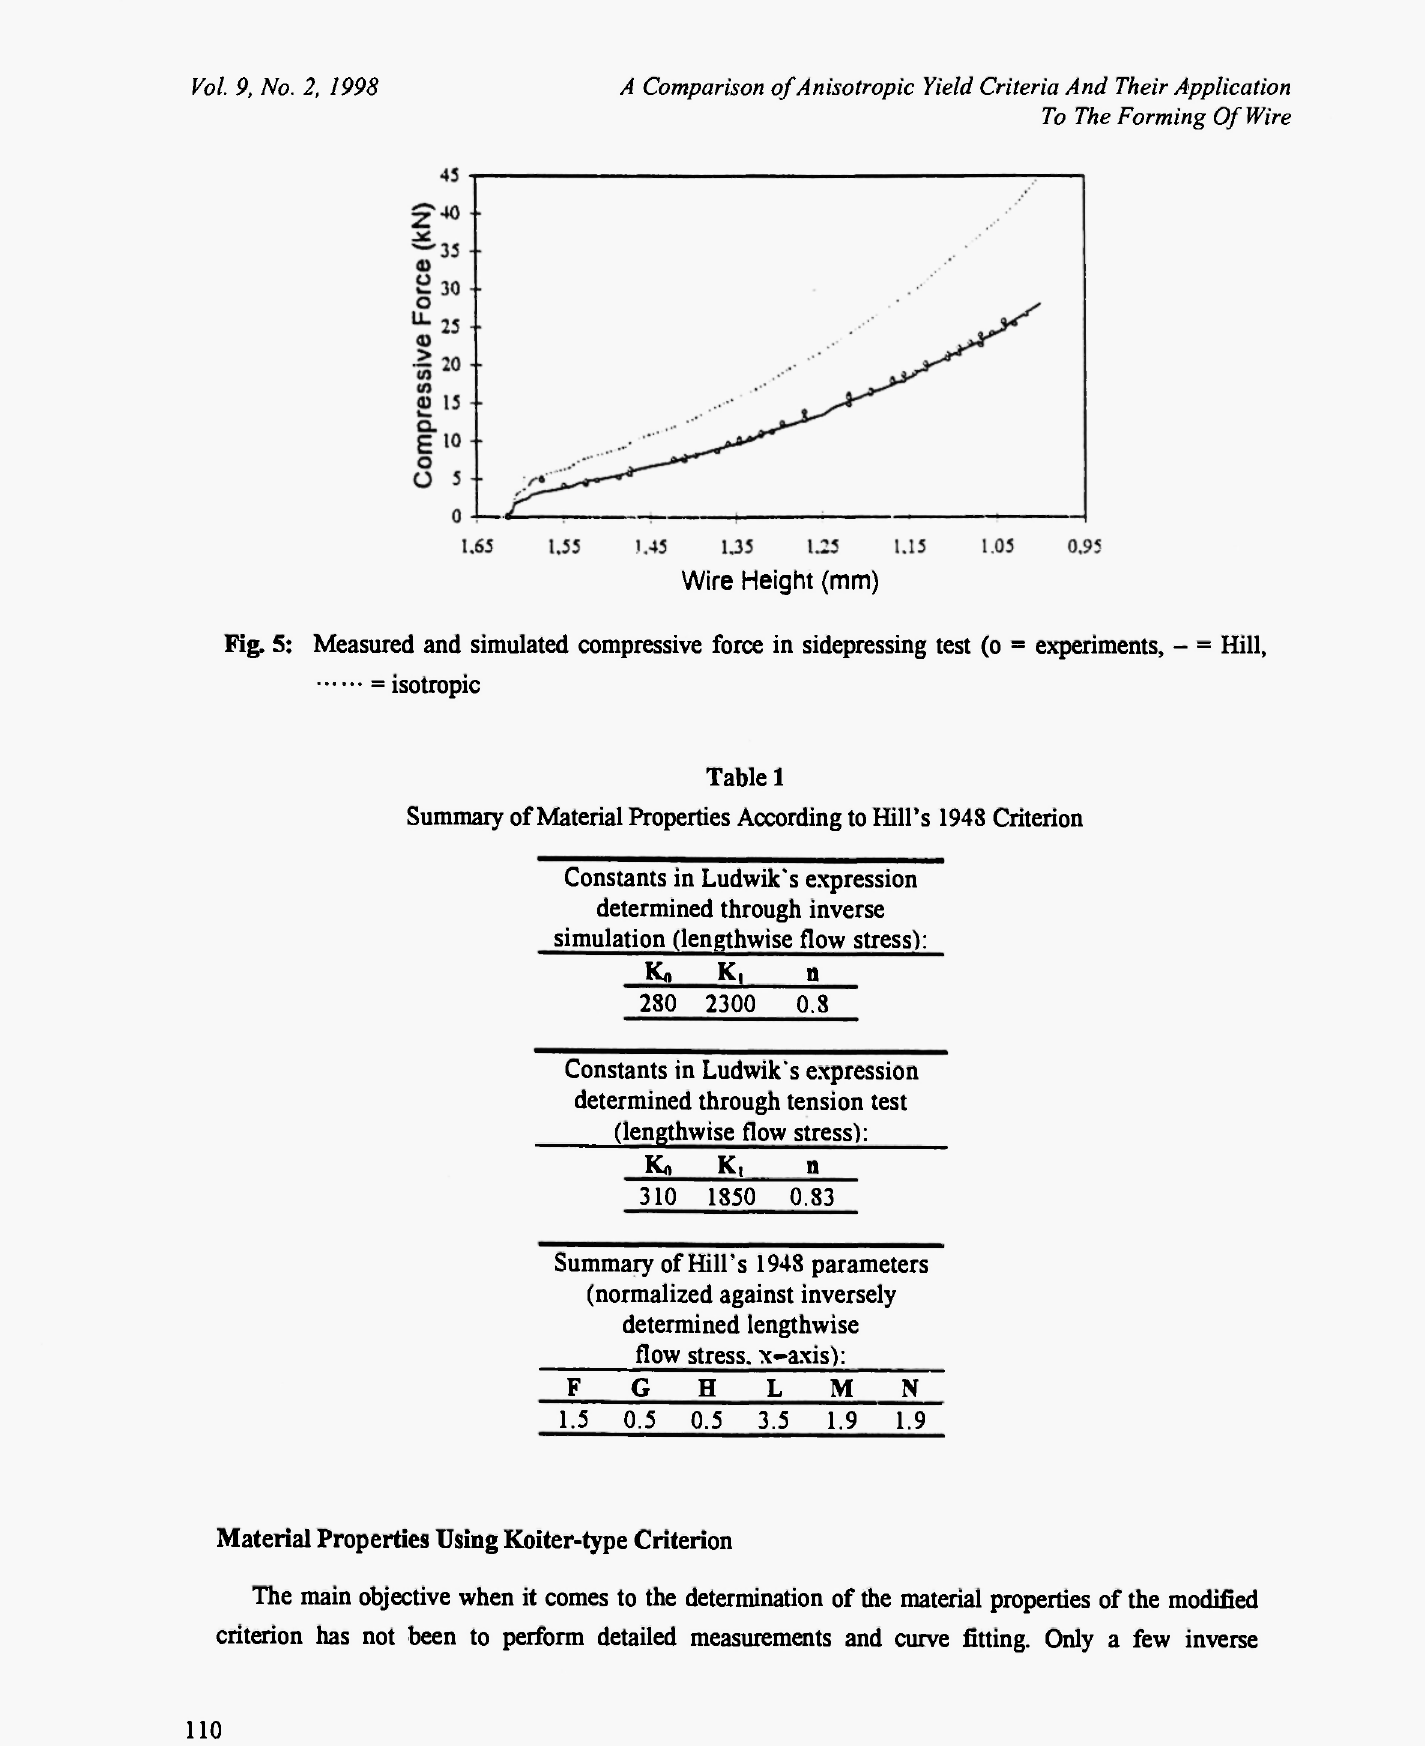
Fig. 5: Measured and simulated compressive force in sidepressing test (o = experiments, - = Hill, isotropic